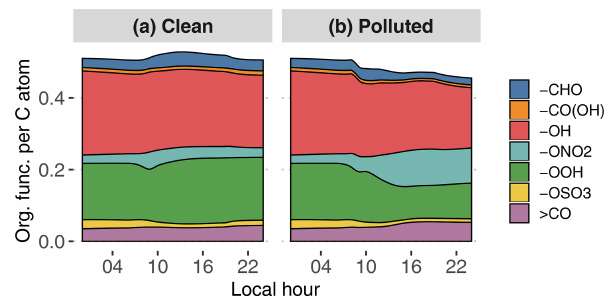
Figure 9. GECKO-A modeled time evolution of particle-phase or- ganic functionalization for the clean (a) and the polluted (b) cases. Functional groups are abbreviated as follows: aldehyde (-CHO), carboxylic acid (-CO(OH)), hydroxy (-OH), nitrate (-ONO2), hy- droperoxide (-OOH), sulfate (-OSO3) and ketone ( > CO). The y axis is read as the number of a given organic function per car- bon atom; i.e., in the clean case there is in total approximately one organic function for every two carbon